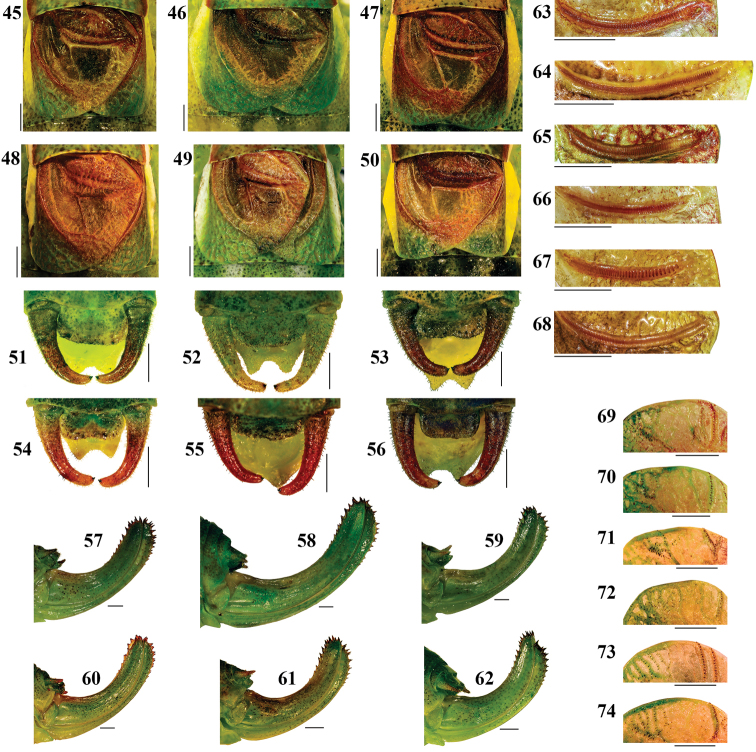
Morphological differences in close–related Isophya species: 45, 51, 57, 63, 69
Isophya dochia sp. n. 46, 52, 58, 64, 70
Isophya harzi, Piatra Craiului Mts. 47, 53, 59, 65, 71
Isophya camptoxypha, Nemira Mts. 48, 54, 60, 66, 72
Isophya ciucasi, Ciucaş Mts. 49, 55, 61, 67, 73
Isophya sicula, Harghita Mts. 50, 56, 62, 68, 74
Isophya nagyi, Călimani Mts. (45–50 male tegmina 51–56 male cerci57–62 ovipositor 63–68 male stridulatory file 69–74 female stridulatory bristles). Scale 1 mm.